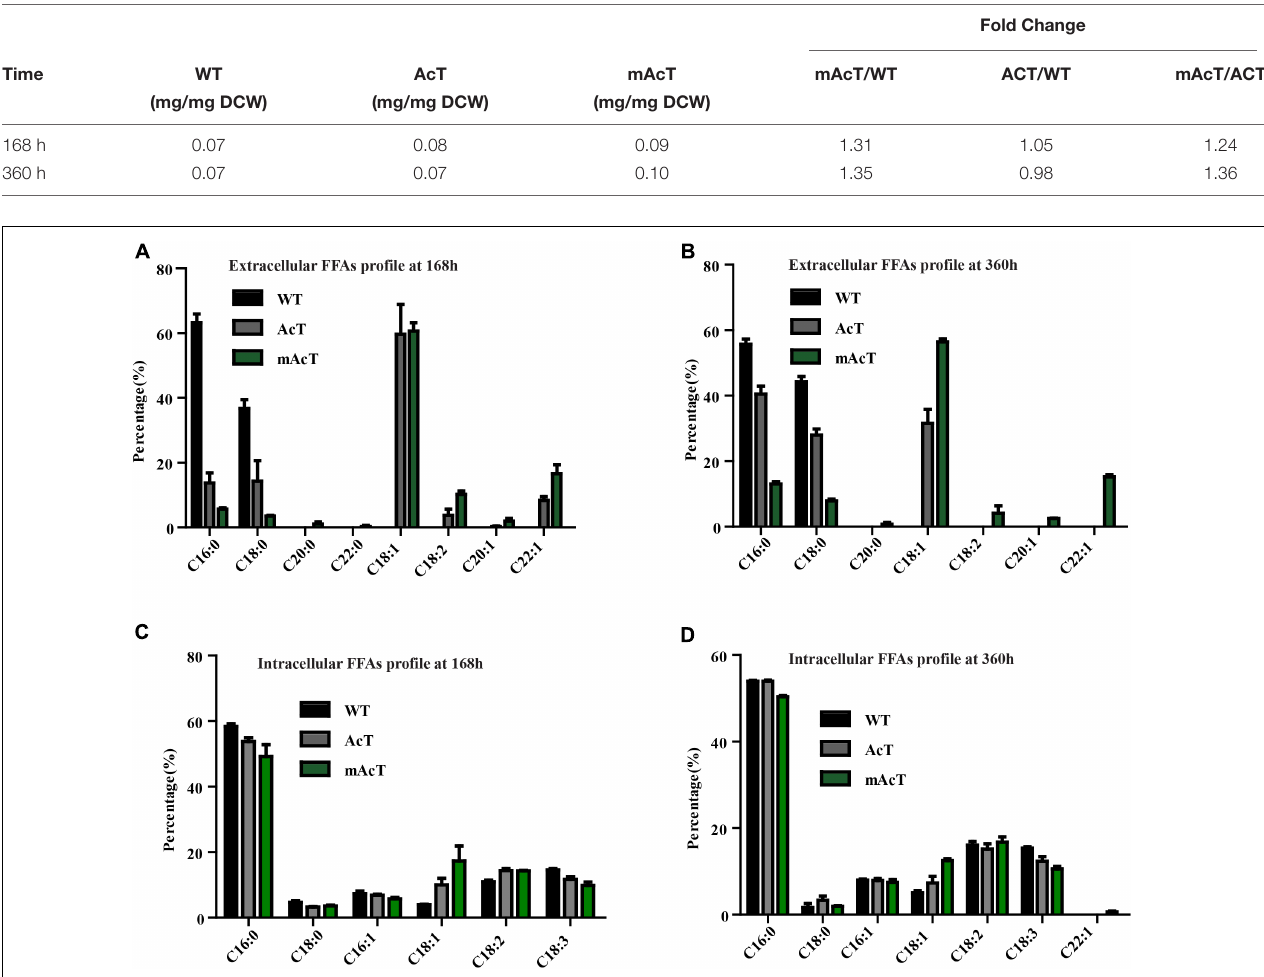
TABLE 2 | The ratio between intracellular FFA and dry cell weight calculated from cells grown under normal growth condition.